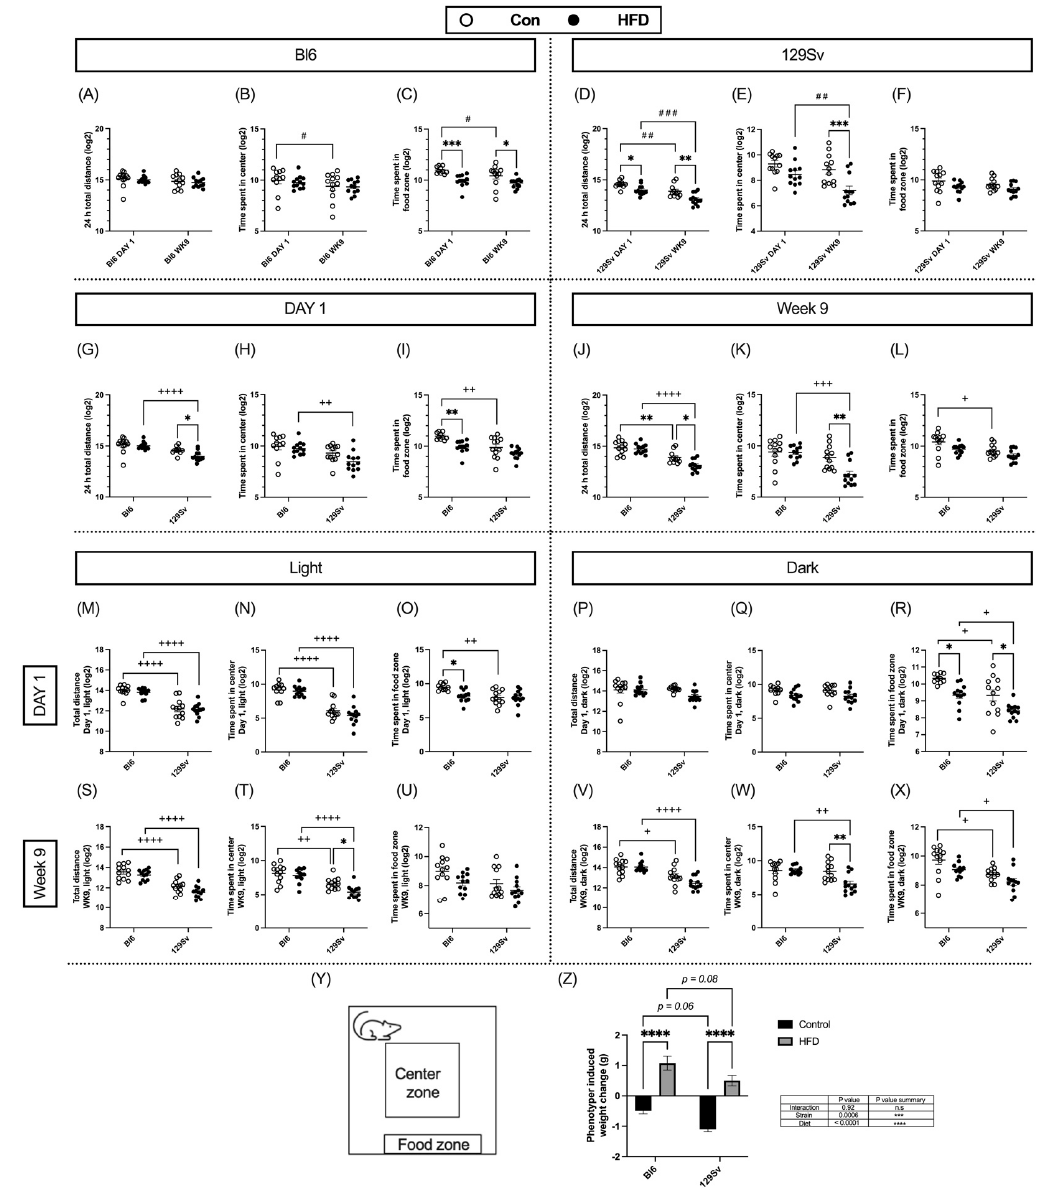
Figure 2. HFD impact on locomotor parameters (Log2 values, data expressed as mean ± SEM). Bl6: Total distance traveled in 24 h ( A ), time spent in center ( B ) and food (C) zone day 1 vs. week 9. 129Sv: Total distance traveled in 24 h ( D ), time spent in center ( E ) and food ( F ) zone day 1 vs. week 9. At the beginning of dietary intervention: Total distance traveled in 24 h ( G ), time spent in center ( H ) and food ( I ) zone Bl6 vs. 129Sv. Week 9 of dietary intervention: Total distance traveled in 24 h ( J ), time spent in center ( K ) and food ( L ) zone Bl6 vs. 129Sv. Total distance traveled at day 1 ( M ) and week 9 ( S ) at lights on period. Total distance traveled on day 1 ( P ) and week 9 ( V ) at dark period. Time spent at the center zone on day 1 ( N ) and week 9 ( T ) at lights on period. Time spent at the center zone on day 1 ( Q ) and week 9 ( W ) at dark period. Time spent at the food zone on day 1 ( O ) and week 9 ( U ) at lights on period. Time spent at the food zone on day 1 ( R ) and week 9 ( X ) at dark period. ( Y ) Representation of Phenotyper test arena indicating the location of defined zones of interest including food and water zone and center zone. ( Z ) Weight change (g) of Bl6 and 129Sv mice induced by week 9 Phenotyper testing. * p ≤ 0.05, ** p ≤ 0.01, *** p ≤ 0.001, **** p ≤ 0.0001 (diet effect), + p ≤ 0.05, ++ p ≤ 0.01, +++ p ≤ 0.001, ++++ p ≤ 0.0001 (strain effect). # p ≤ 0.05, ## p ≤ 0.01, ### p ≤ 0.001 (time